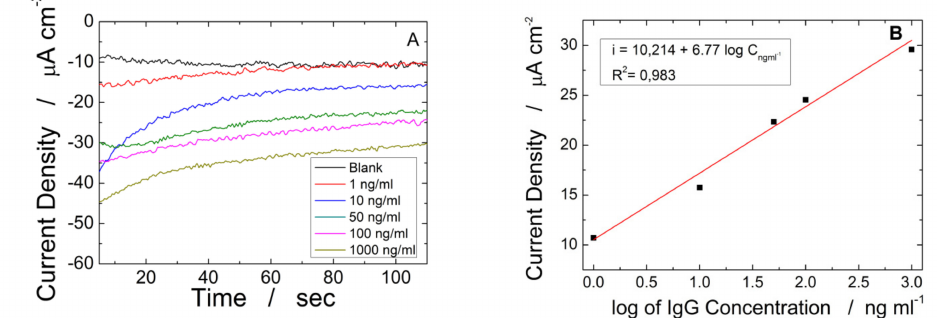
Figure 9. Electrochemical characterization of immunosensors fabricated on of ITO-PET/ZnO NRs/rGO substrate: ( A ) chronoamperometric curves and ( B ) respective calibration curve. The ZnO electrode was obtained at − 0.95 V vs. Ag/AgCl for 60 min in a de-aerated solution of 10 mM ZnCl2 and 10 mM NaNO 3 at pH